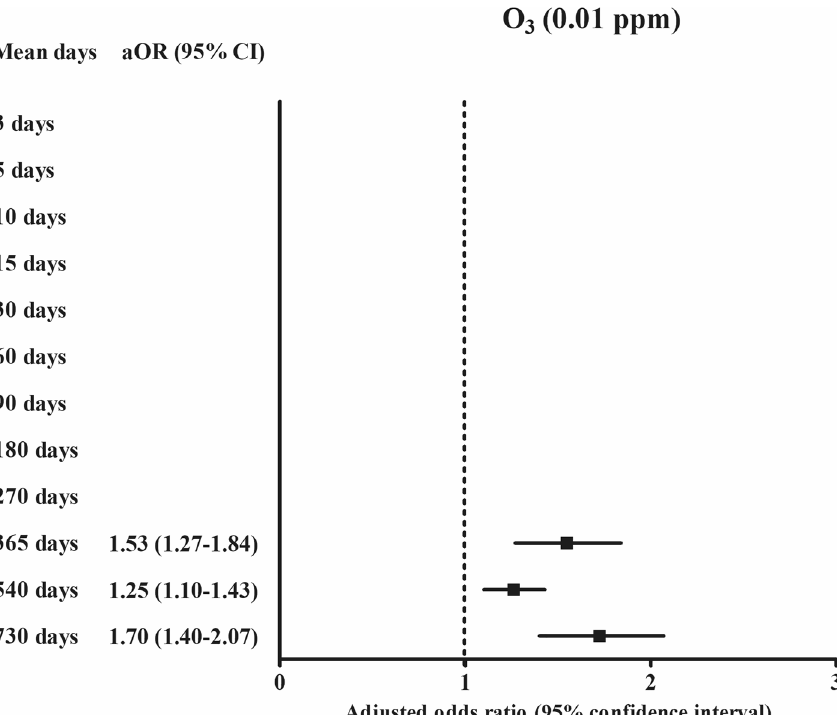
Figure 3. The odds ratios (95% confidence interval) of O 3 (0.01 ppm) for 365 days, 540 days, and 730 days for ischemic heart